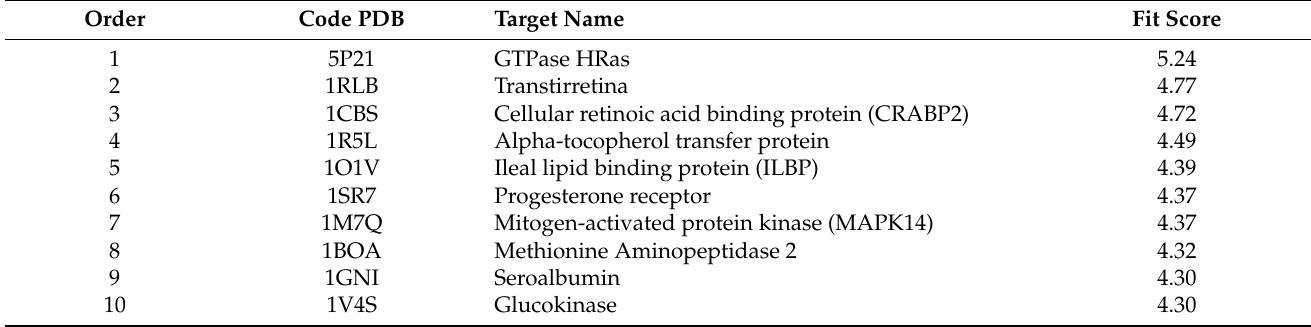
Table 3. Prediction of possible targets for Annonacin.